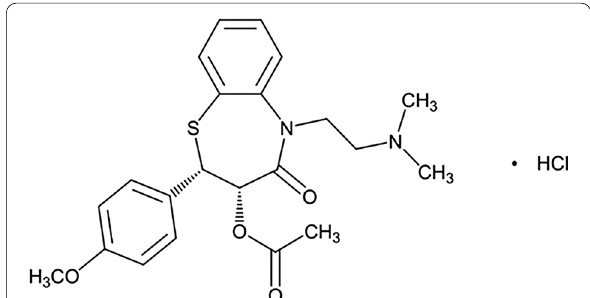
Fig. 1 Chemical structure of diltiazem